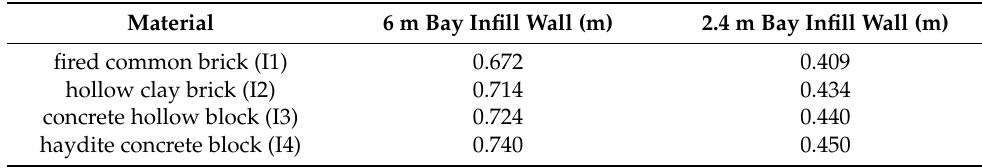
Table 12. The effective width of equivalent struts of simplified